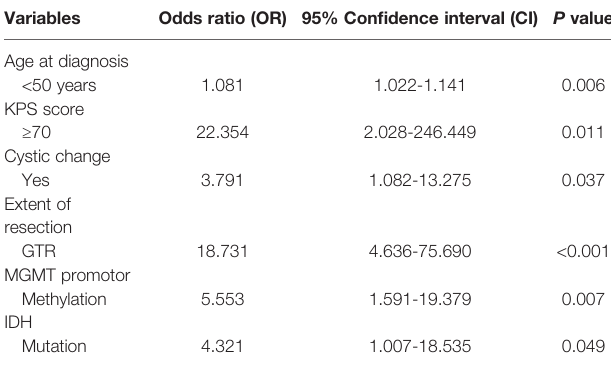
TABLE 2 | Results of multivariate logistic regression analysis. Variables